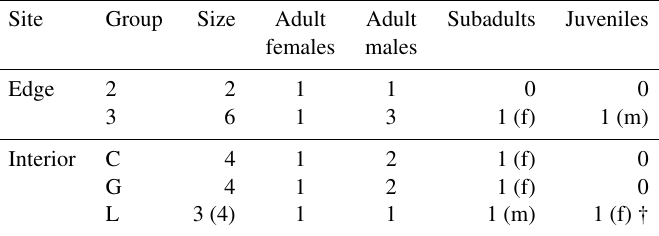
Table 1. Composition of the five study groups at the two study sites (“f” denotes females, and “m” denotes males). Site Group Size Adult Adult Subadults Juveniles females males Edge 2 2 1 1 0 0 3 6 1 3 1 (f) 1 (m) Interior C 4 1 2 1 (f) 0 G 4 1 2 1 (f) 0 L 3 (4) 1 1 1 (m) 1 (f) † † represents that animals died or disappeared during the